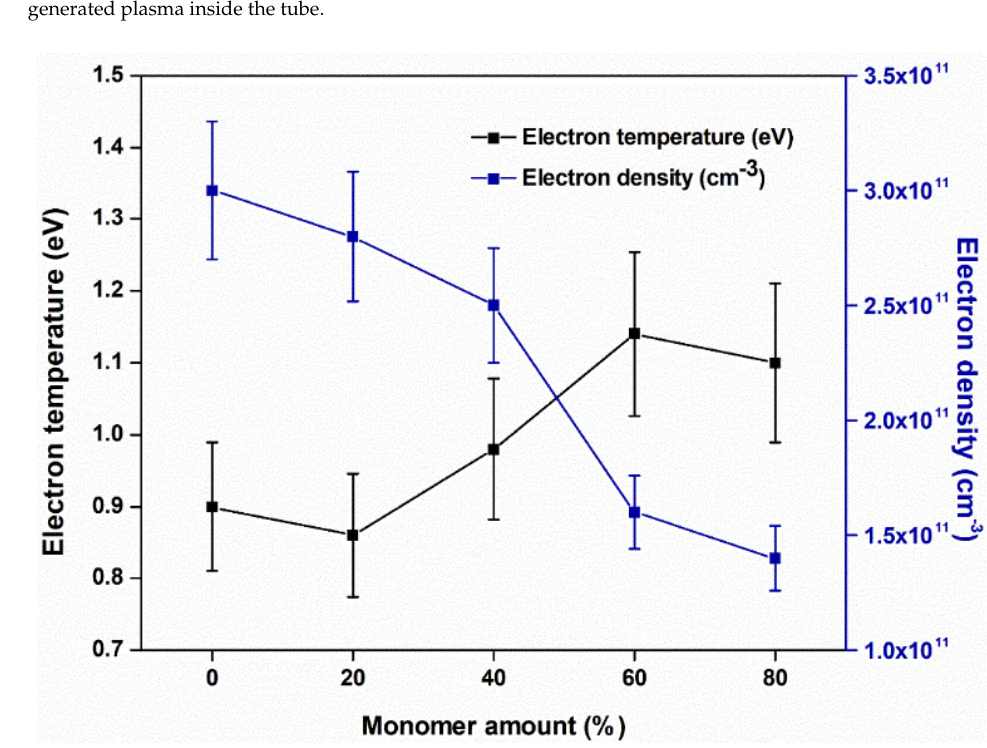
Figure 4. Plot for electron temperature and electron density with respect to changing monomer amount. The unit of monomer amount indicates the volume percentage. Table 2. Results of calculations for T e and n e , as well as sheath thickness, as a function of MMA concentrations, (RF power = 100 Watt).